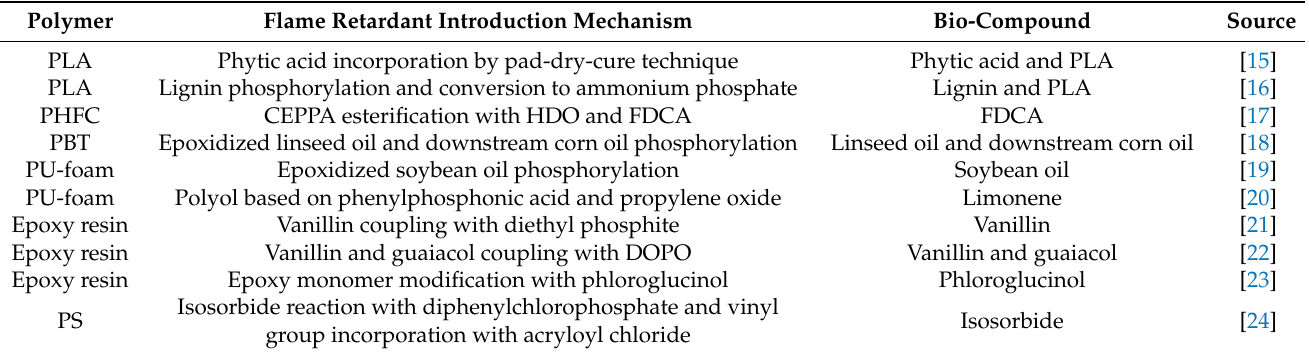
Table 1. Some examples of incorporation of phosphorus to bio-based